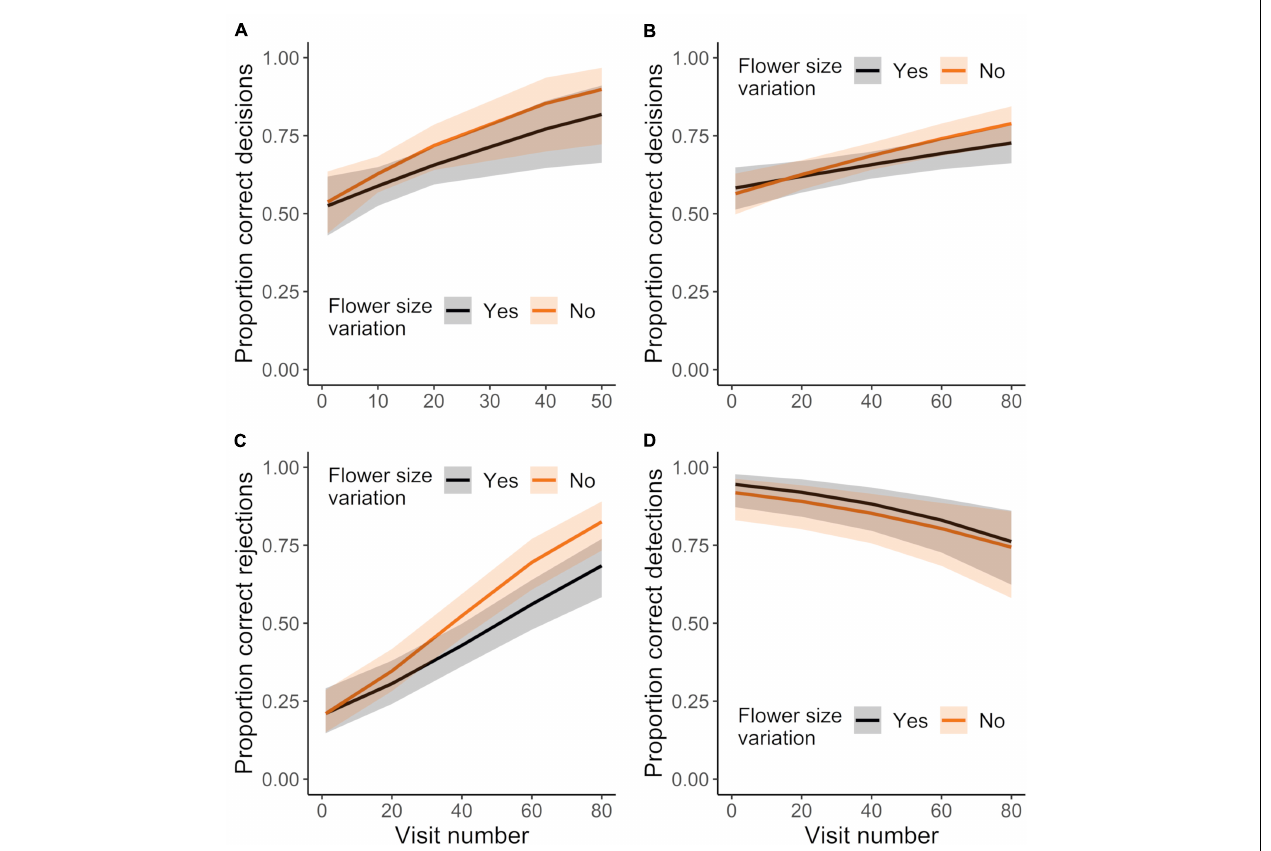
FIGURE 5 | Sampling behavior of initially-naïve bees foraging in treatments that did or did not vary in corolla size. (A) Mean proportion of correct decisions for those bees that met the learning criterion, only considering visits up to the point of meeting the criterion. N = 14 and 12 bees in the control and corolla size variation treatment, respectively. Mean proportion of (B) correct decisions, (C) correct rejections, and (D) correct detections made by all bees making up to 80 visits. N = 15 and 18 bees in the control and variation treatment, respectively (includes those bees in panel “ A ”). Plotted lines indicate estimated means and shaded regions indicate 95% confidence